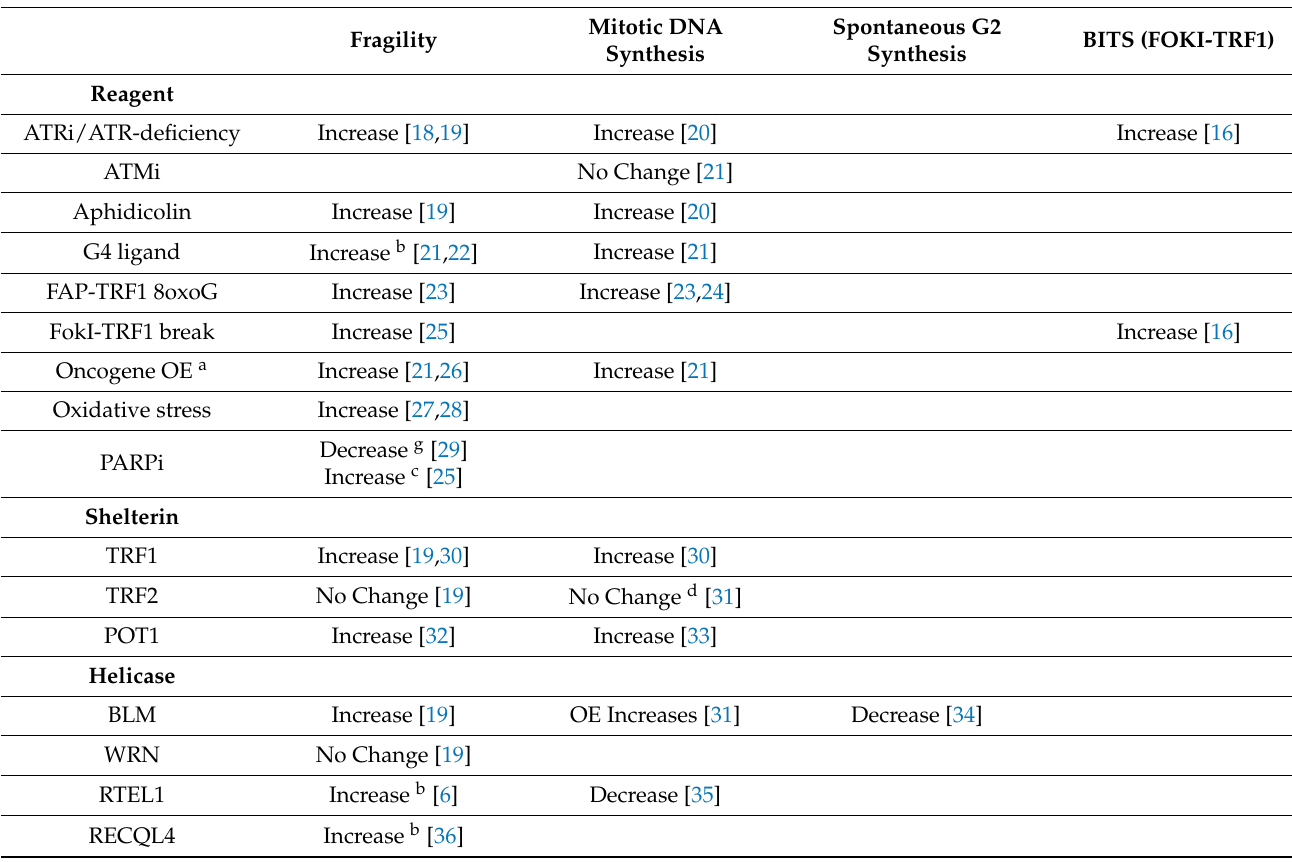
Table 1. List of experimental manipulations and genetic depletions that impact telomere fragility, telomere mitotic DNA synthesis, spontaneous telomere DNA synthesis in G2 (ALT), and FokI-TRF1 induced DNA synthesis in G2/M. Effects of Protein Depletion or Reagent Addition * Mitotic DNA Spontaneous G2 Fragility Synthesis